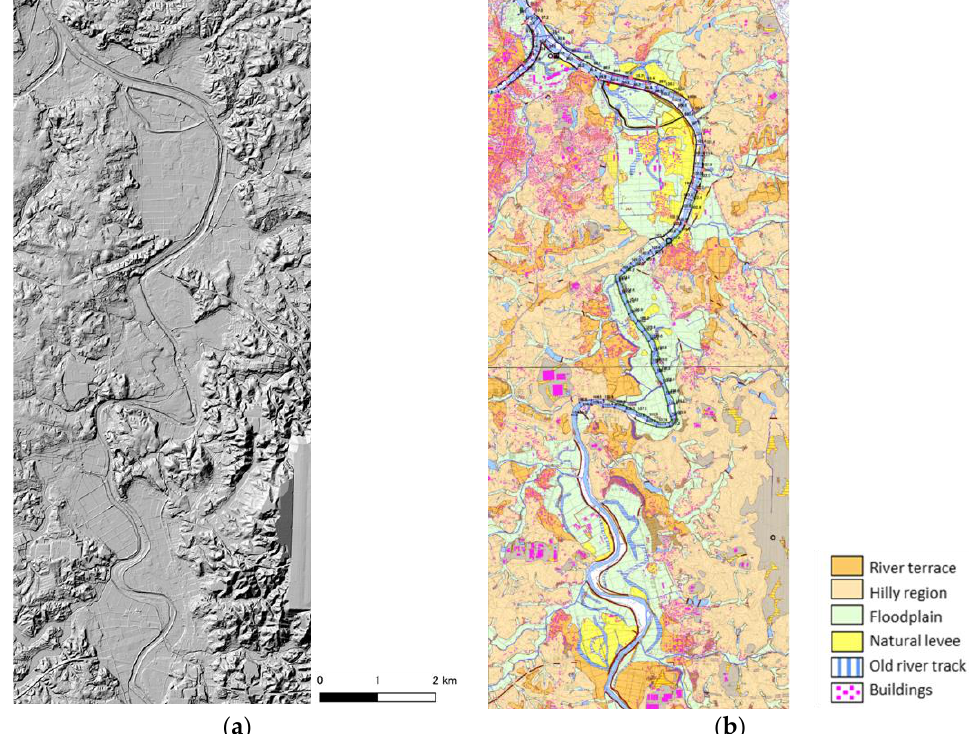
Figure 3. Example of topography of upper river basin (Abukuma River); ( a ) shaded relief map and ( b ) landform classification map for flood control.